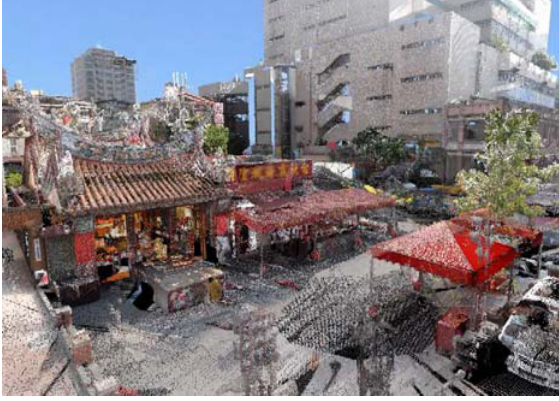
Figure 1. Point clouds of Taipei Xia-Hai City God temple